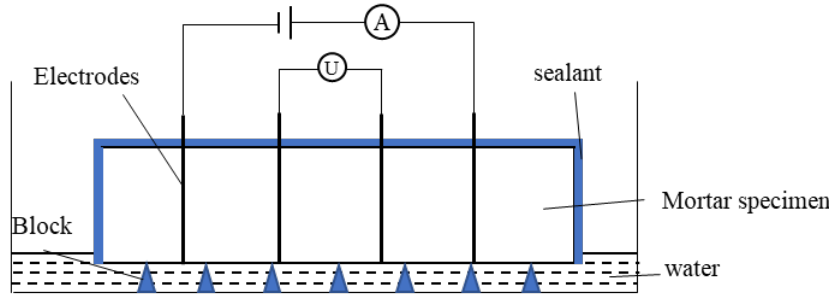
Figure 2. Schematic diagram of capillary water absorption and resistivity testing of mortar speci- mens [28,29]. Table 3. Timing and tolerance of capillary water absorption quality tests.